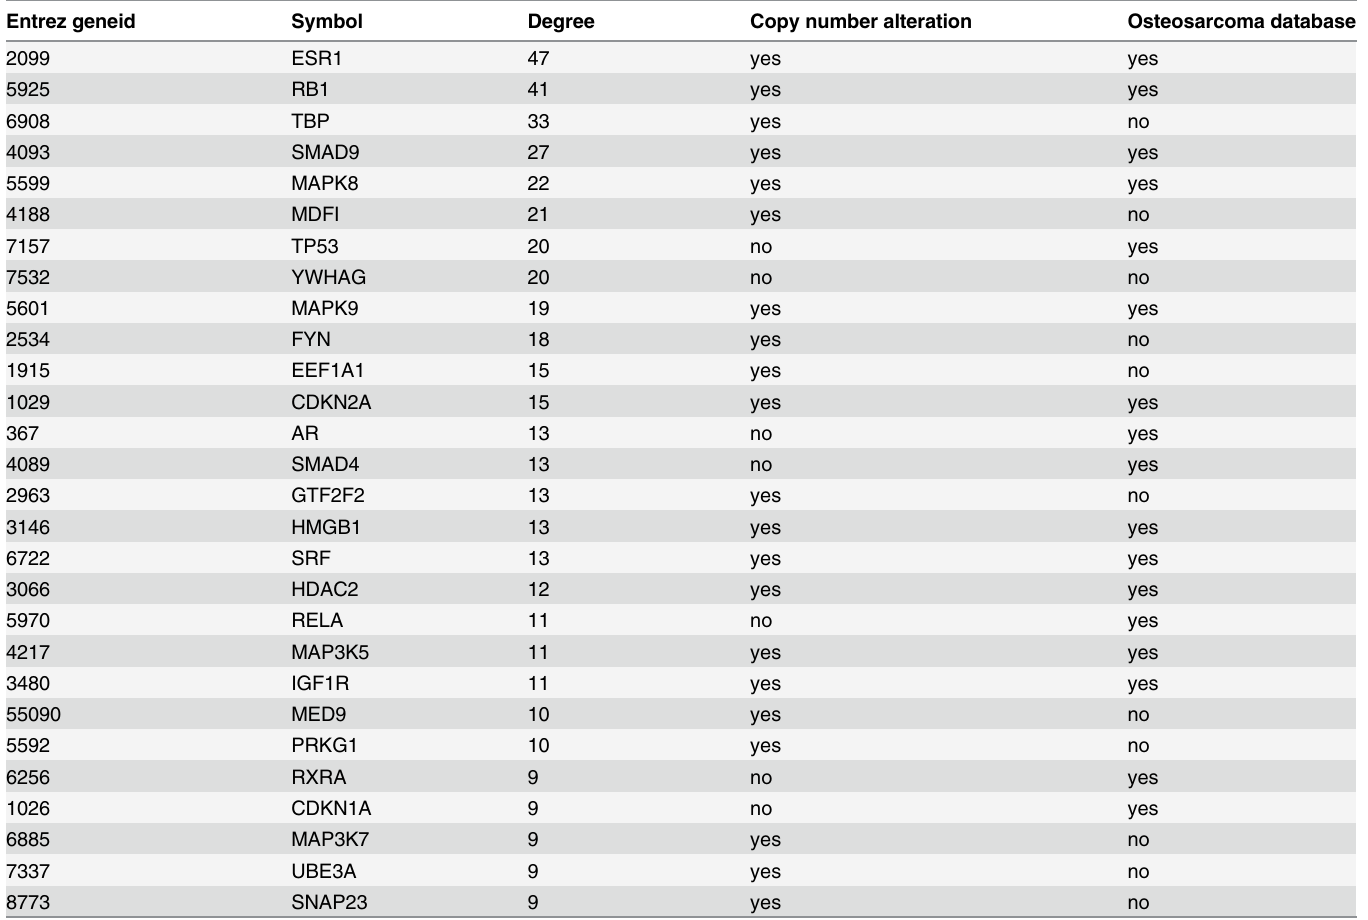
Table 3. Global hub genes within the osteosarcoma network.